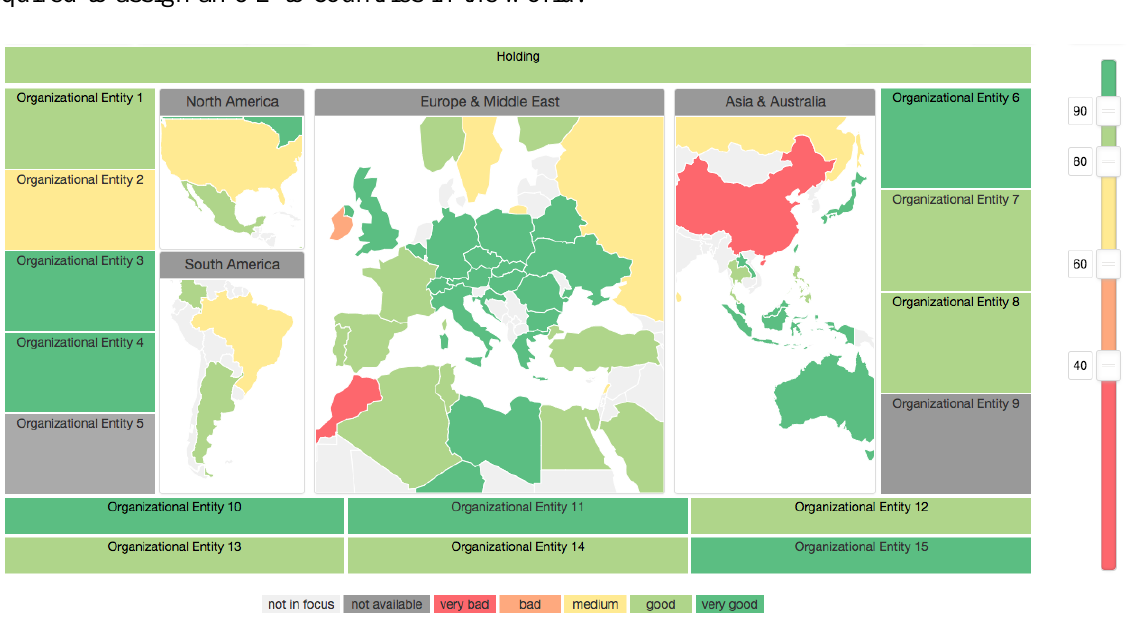
Figure 6. World map to visualize